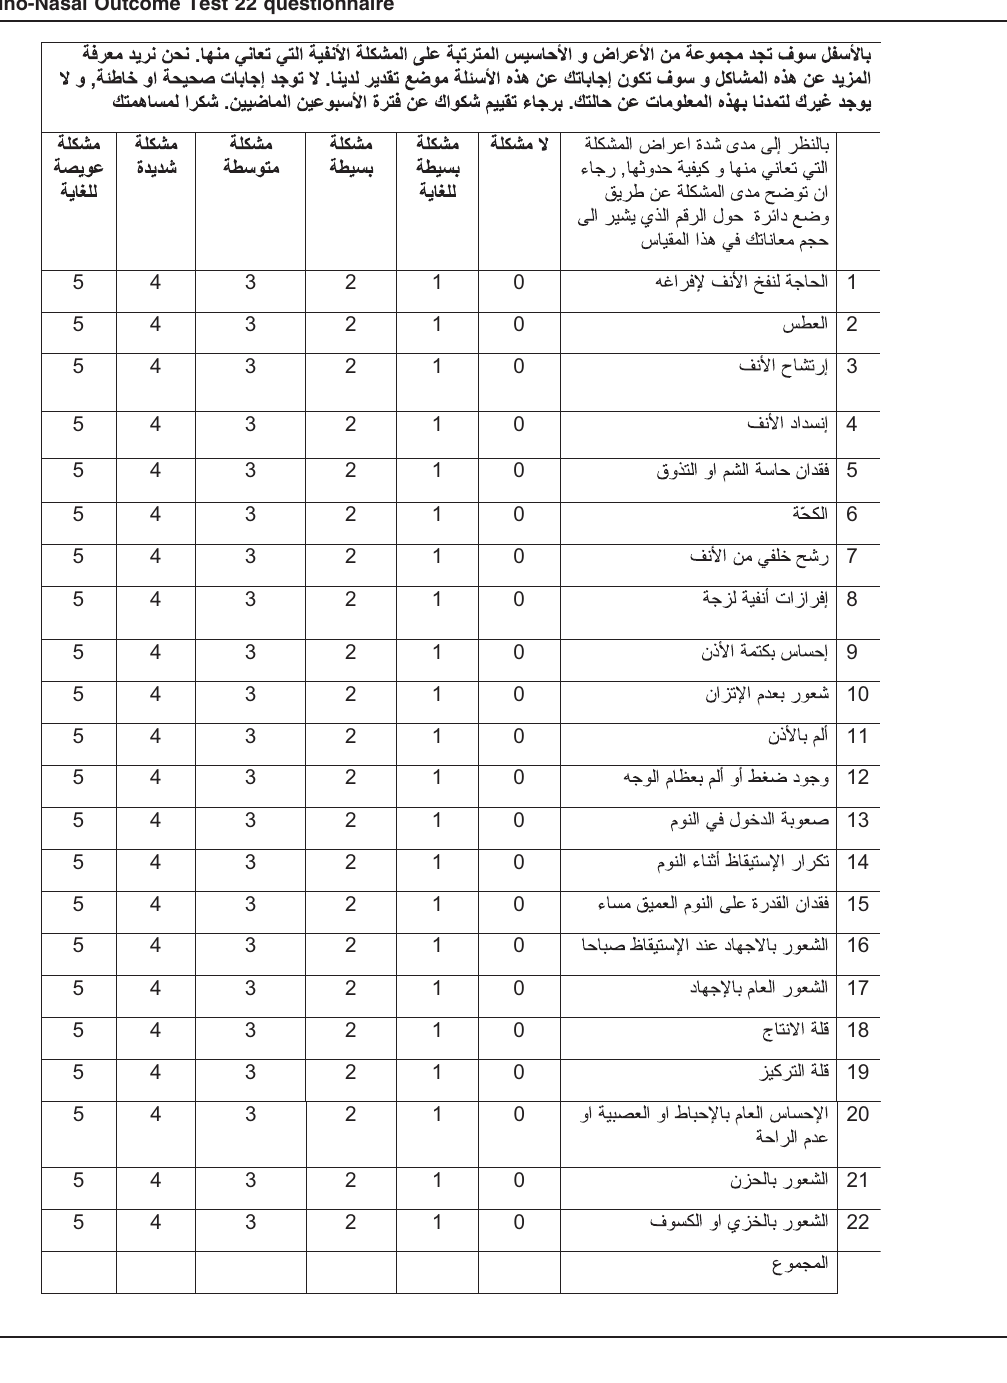
Table 2 Arabic Sino-Nasal Outcome Test 22 questionnaire